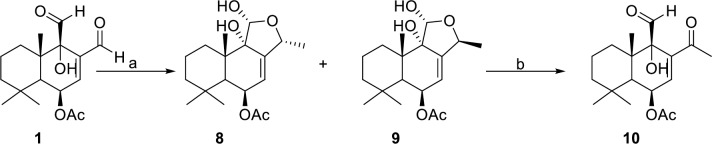
Synthesis of lactols 8 and 9, and formation of 10 from lactol 9.Reagents and conditions: (a) 1 equiv MeMgBr, THF, −78°C, 2 h; (b) CDCl3, 22 d.